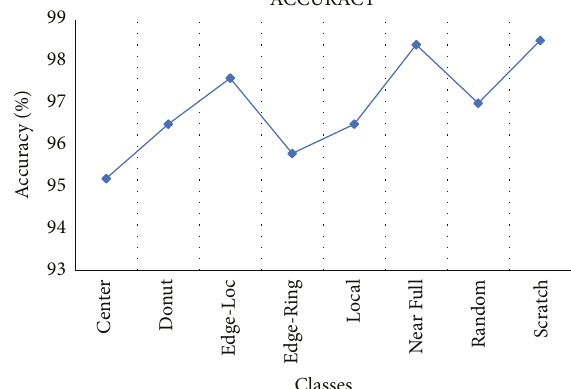
Figure 7: Graphical plot of ShuffleNet-v2-CNN’s accuracy